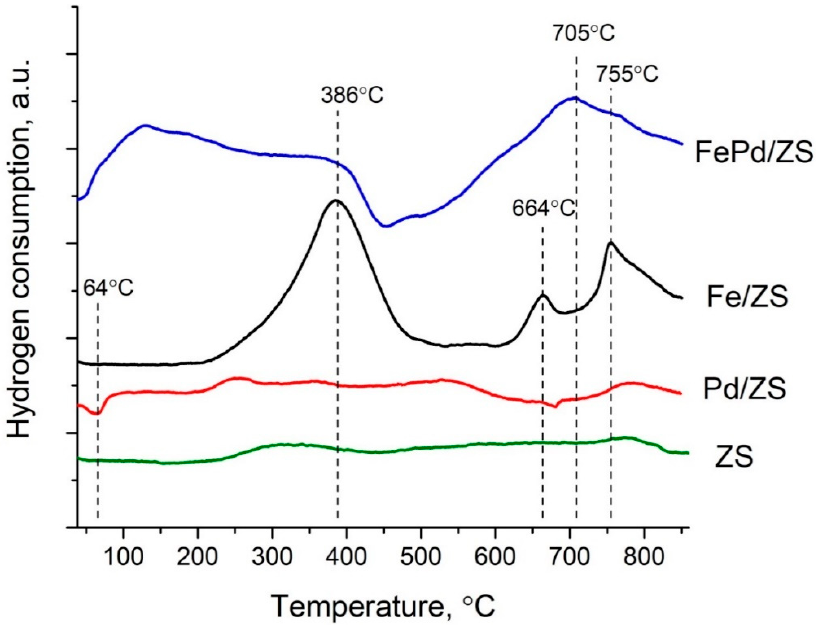
Figure 4. TPR-H 2 profiles of the ZS support and unreduced